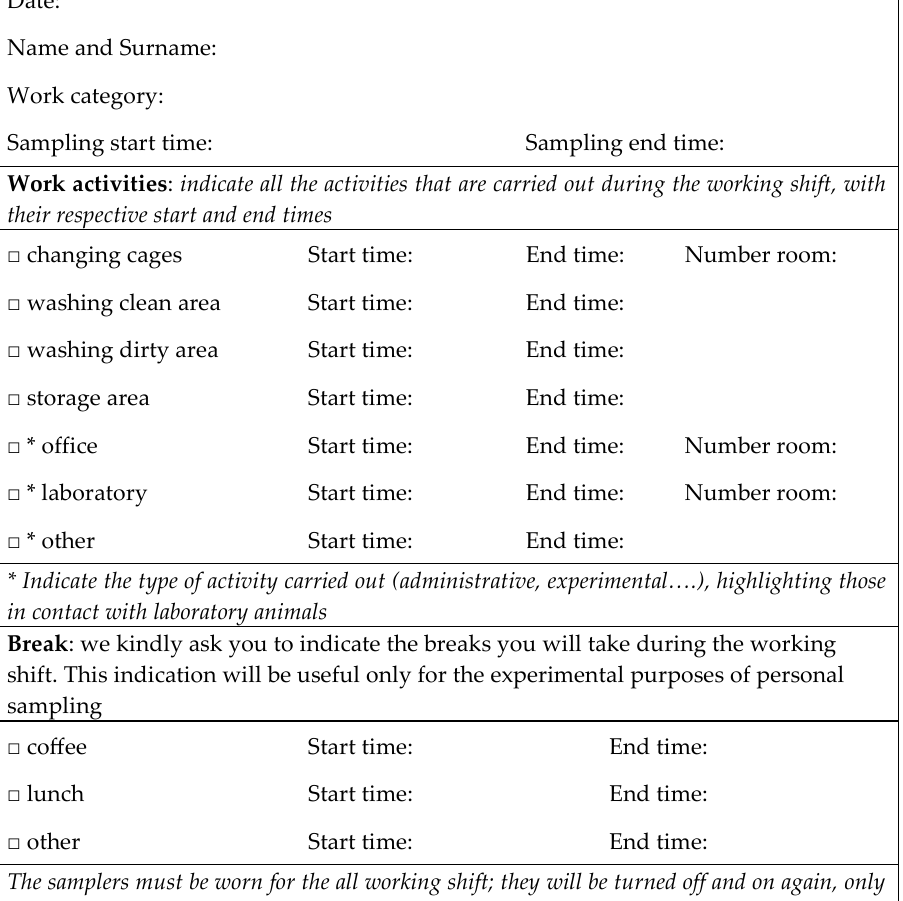
Figure 1. Work record sheet utilized to collected information on enrolled workers.